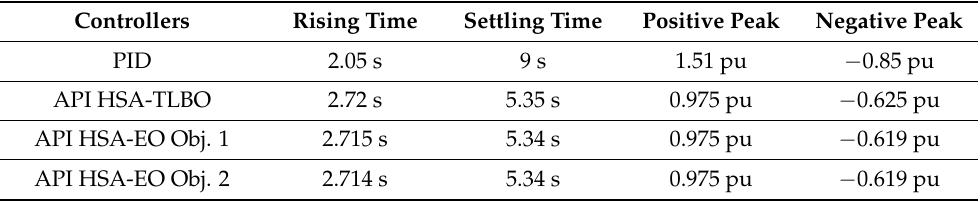
Table 2. Numerical comparison between the controllers at normal first